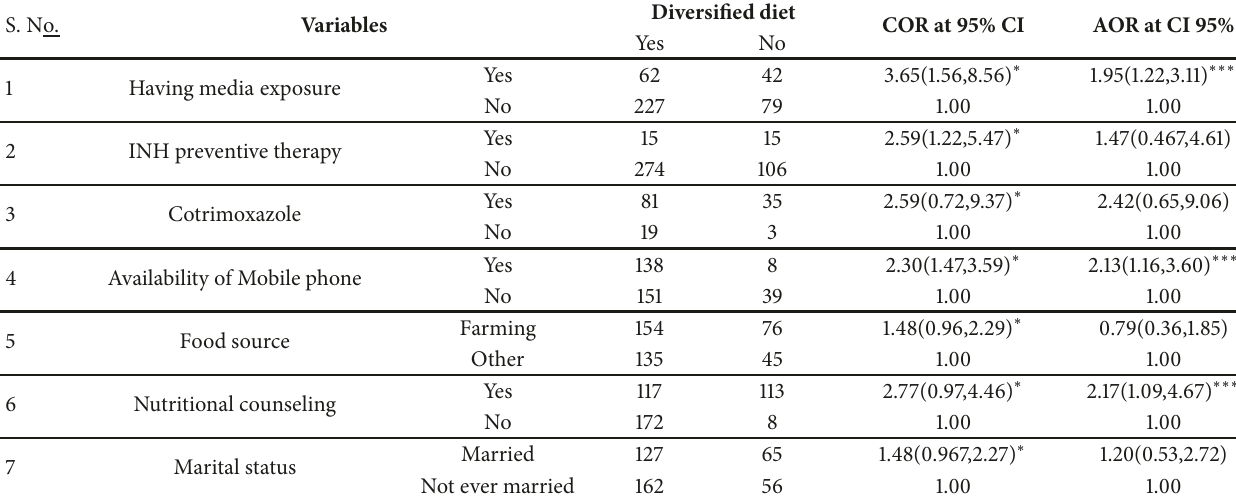
Table 3: Multivariate and bivariate logistic regression output showing factors associated with dietary diversity in adult HIV patients in Motta town public health facilities, April,